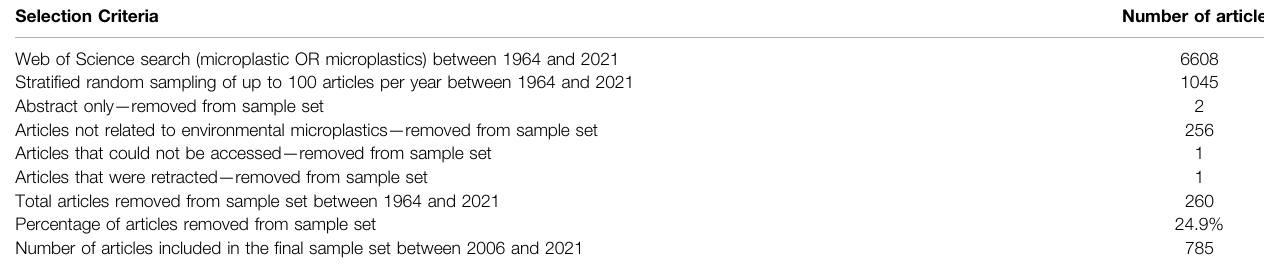
TABLE 1 | The selection criteria and number of peer-reviewed journal articles that were identi fi ed and used for data analysis in this study. Selection